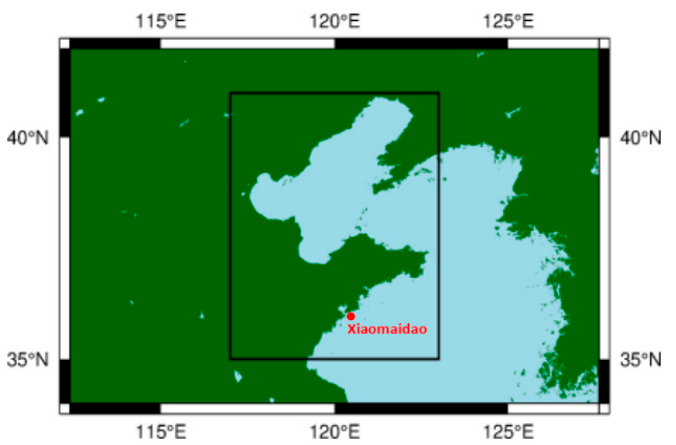
Figure 5. Model domain and the buoy position.